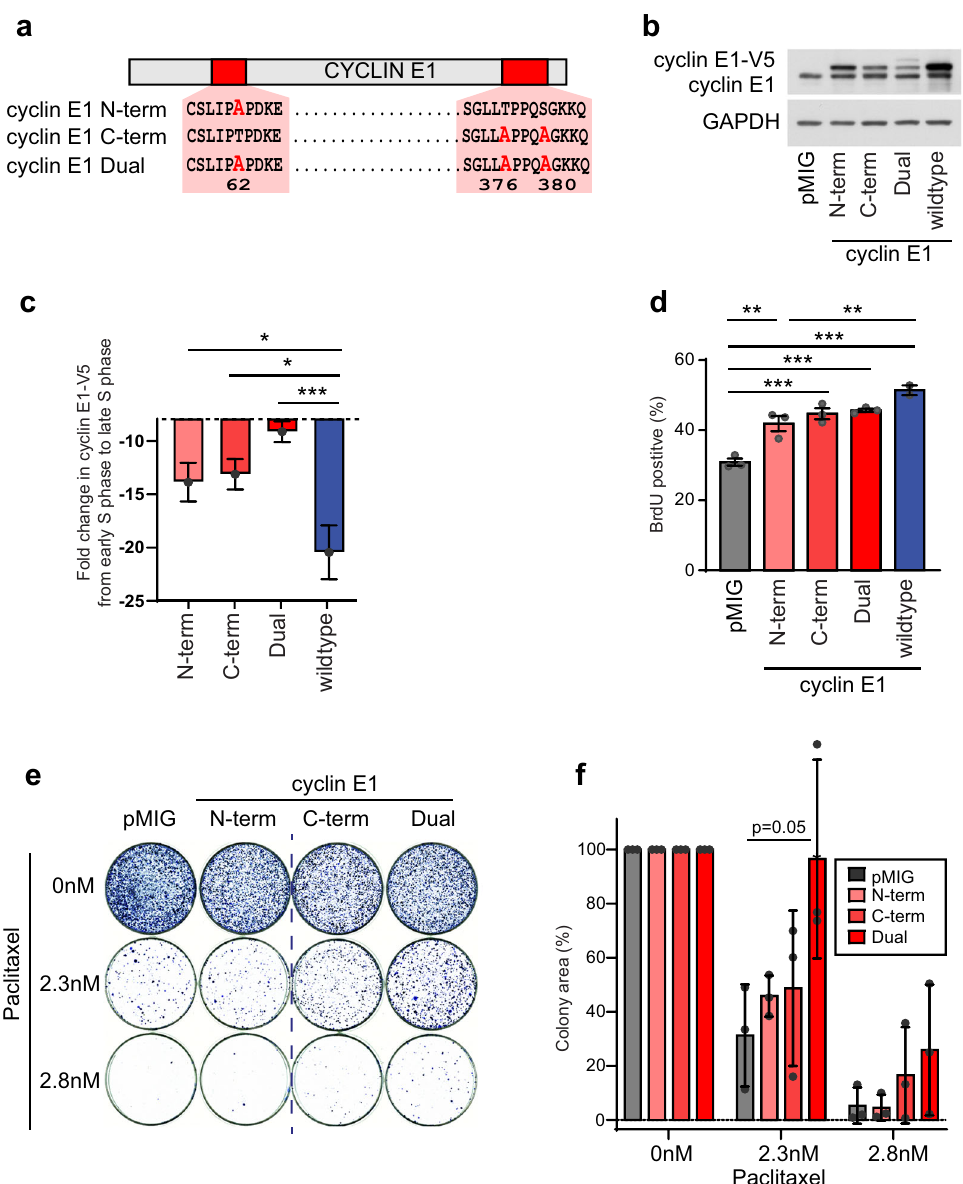
Fig. 4 BRCA1 loss leads to decreased cyclin E1 T62 phosphorylation, which alters protein stability, and contributes to proliferation and cell survival. a Schematic of site-directed mutagenesis of phospho-sites of cyclin E1. b MDA-MB-468 cells were retrovirally infected with V5- tagged cyclin E1 constructs (N-term, C-term, Dual, wildtype), sorted by fl ow cytometry for populations with matched GFP expression, and lysates western blotted for cyclin E1 and GAPDH. All blots derive from the same experiment and were processed in parallel. c MDA-MB-468 cells expressing cyclin E1 constructs (N-term, C-term, Dual, wildtype) were analyzed by fl ow cytometry for V5-cyclin E1 expression and DNA content (propidium iodide). The geometric mean expression of cyclin E1 at early S and late S phase was quantitated for each treatment, and the fold change from early to late S phase is shown as the mean ± s.e.m. Data analyzed by one-way ANOVA; * p < 0.05, *** p < 0.001. Representative experiment of triplicate experiments is shown. d MDA-MB-468 cells expressing cyclin E1 constructs (N-term, C-term, Dual, wildtype) were analyzed by fl ow cytometry for BrdU incorporation. Data are the mean ± s.e.m. of triplicate experiments or as marked, analyzed by one-way ANOVA; ** p < 0.01, *** p < 0.001. e MDA-MB-468 cells expressing different constructs (pMIG, N-term, C-term, Dual) were treated with paclitaxel (0 nM, 2.3 nM, 2.8 nM) for 3 weeks, and colony-formation detected with Diff Quick Stain 2. f Colony formation was quantitated using the ColonyArea ImageJ plugin from triplicate assays. Data are the mean ± s.e.m. analyzed by one-way ANOVA at 2.3 nM paclitaxel